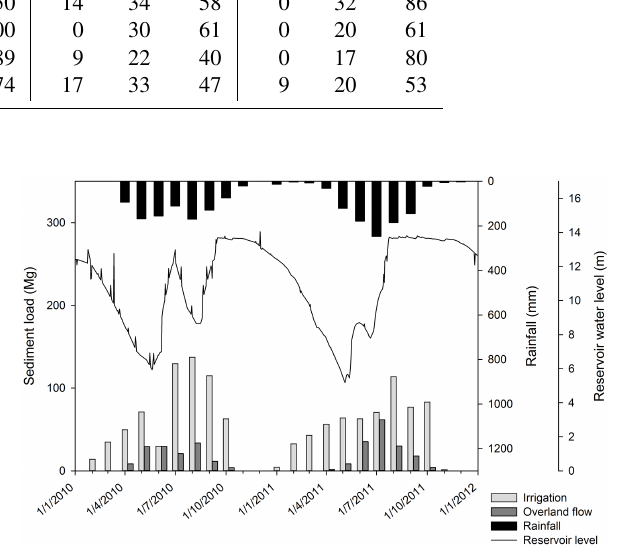
Figure 4. Monthly variations in rainfall, reservoir water level and sediment load inputs to the paddy fields, both from the surface reser- voir and from overland